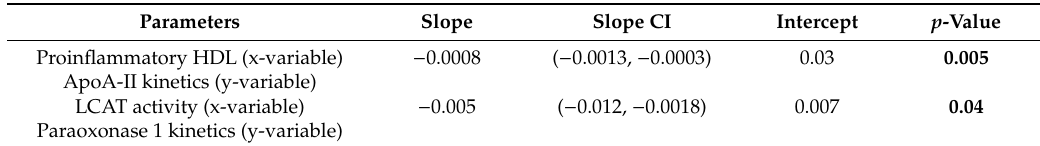
Table 5. Regression analysis (T2D